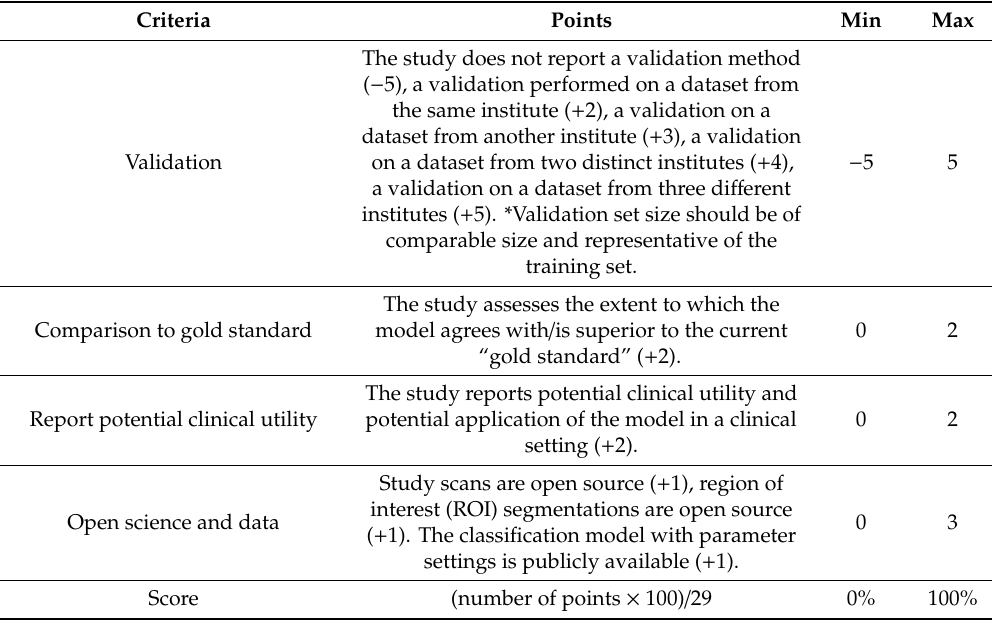
Supplementary Materials Section S1: Search strategy, Table S1: Table with summary of extracted parameters regarding data sets from included papers, Table S2: Table with summary of extracted parameters regarding MRI data from included papers, Table S3: Table with summary of extracted parameters regarding model’s performance and methodology from included